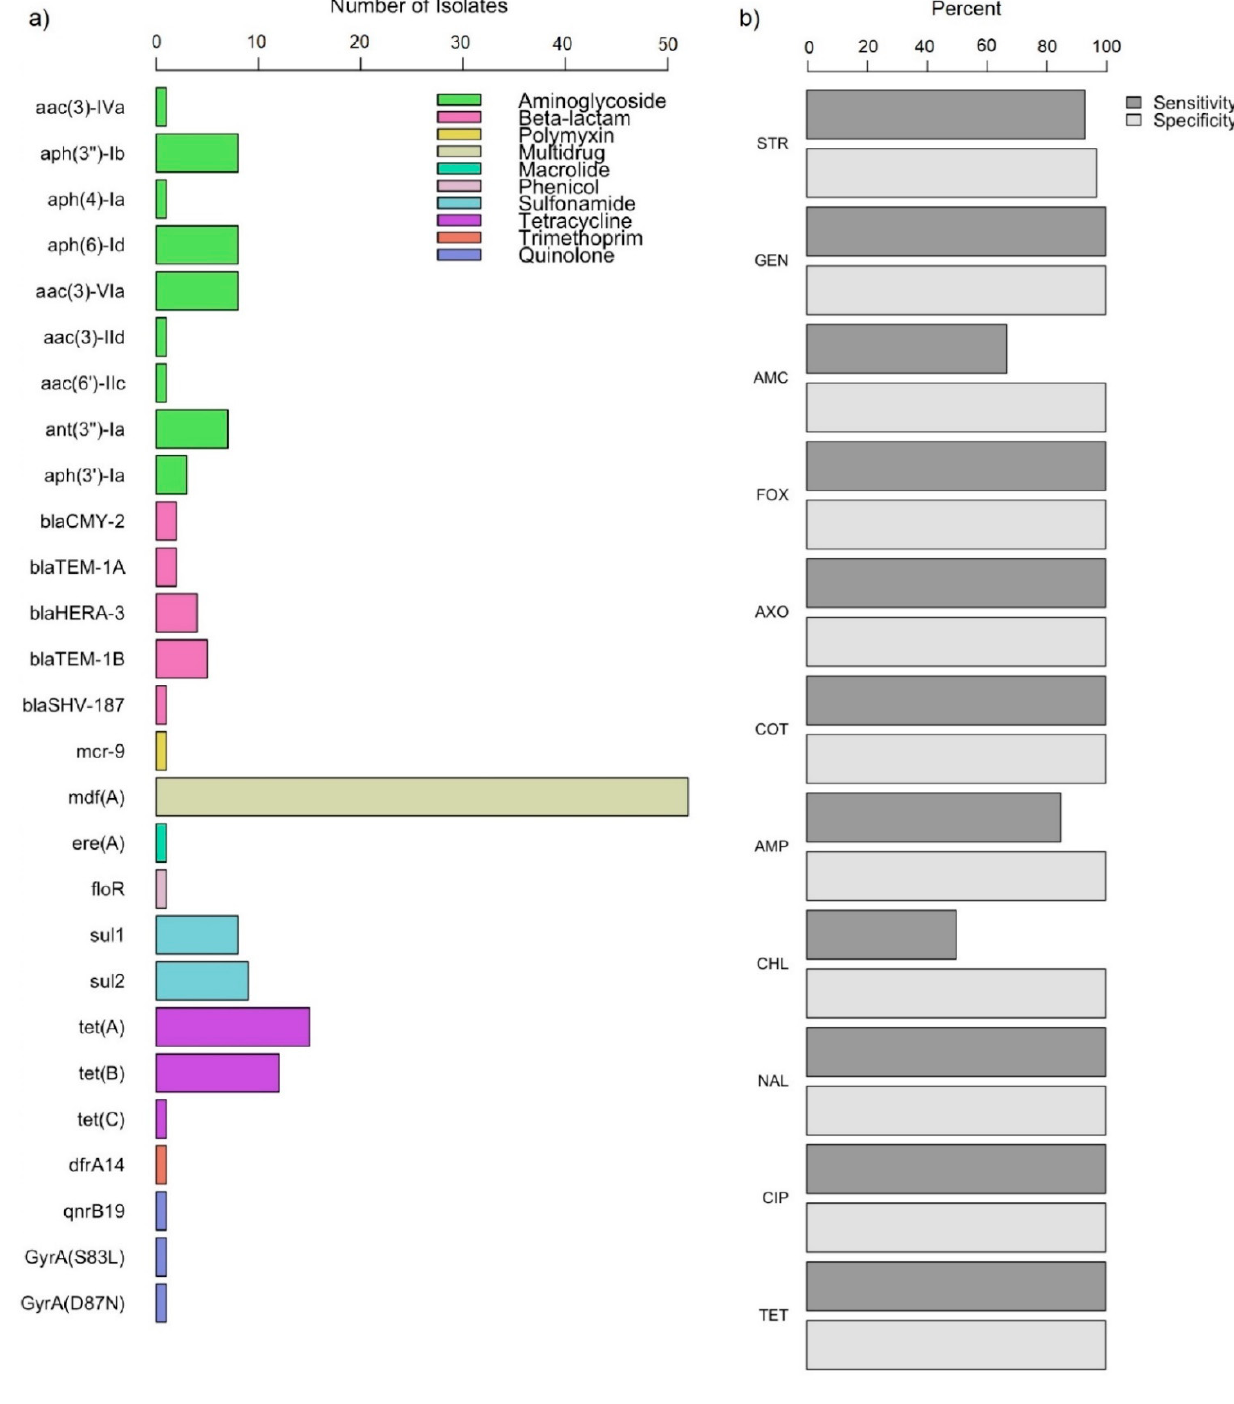
Figure 1. Genomic antimicrobial resistance in E. coli isolates from retail meat (n = 52), by ( a ) distribution of antimicrobial resistance genes and ( b ) concordance with phenotypic antimicrobial resistance. STR: streptomycin; GEN: gentamicin; AMC: amoxicillin/clavulanic acid; FOX: cefoxitin; AXO: ceftriaxone; COT: trimethroprim-sulfamethoxazole; AMP: ampicillin; CHL: chloramphenicol; NAL: nalidixic acid; CIP: ciprofloxacin; TET: tetracycline.